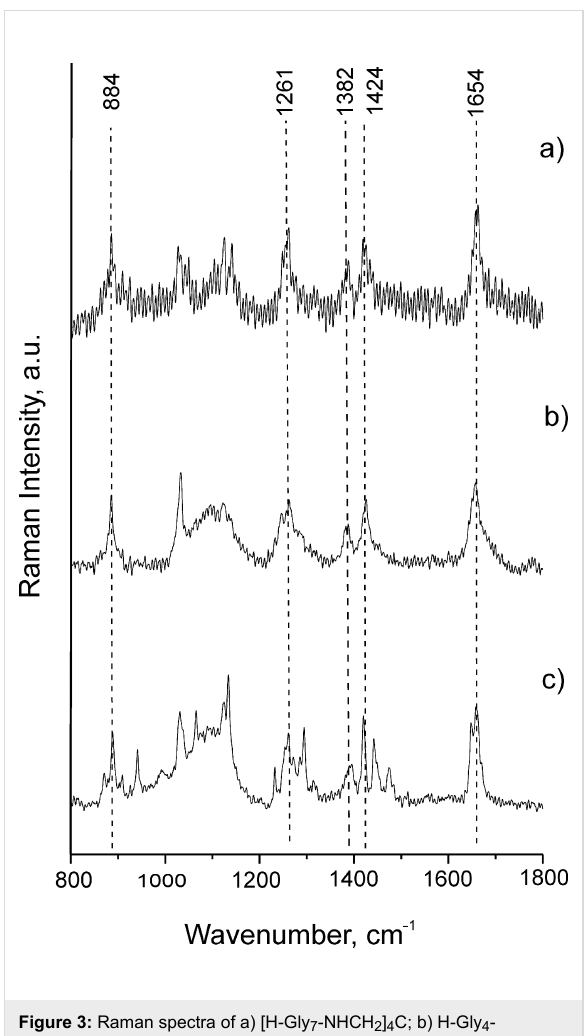
Figure 3: Raman spectra of a) [H-Gly 7 -NHCH 2 ] 4 C; b) H-Gly 4 - NH(CH 2 ) 2 NH-Gly 4 -H; c) H-Gly 4 -NH(CH 2 ) 10 NH-Gly 4 -H. The spectra contain characteristic bands at 884, 1261, 1382, 1424 and 1654 cm − 1 , corresponding to the structure PG II [12]. Spectra were recorded for the samples in solid